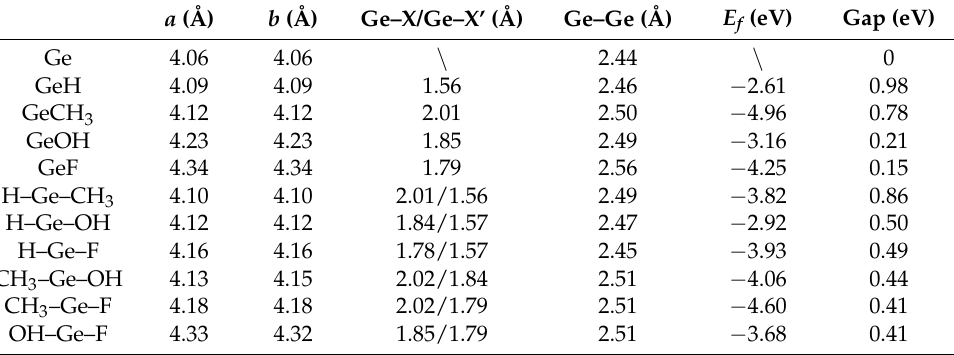
Table 1. Structural parameters (Å), formation energies E f (eV per unit cell) and band gaps (eV) determined for germanene functionalized with several